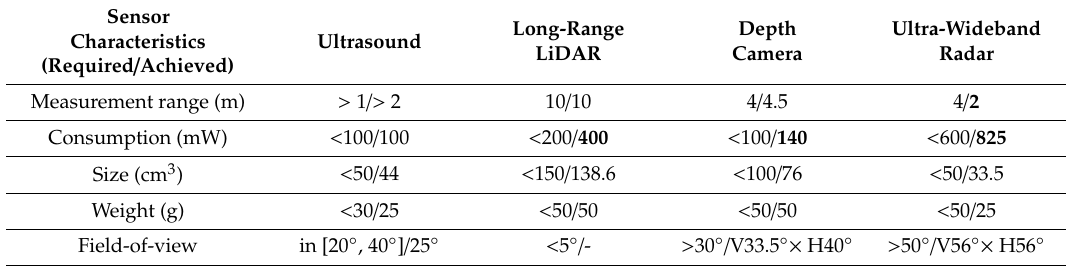
Table 7. Sensing modules requirements vs. characteristics of the optimized modules.